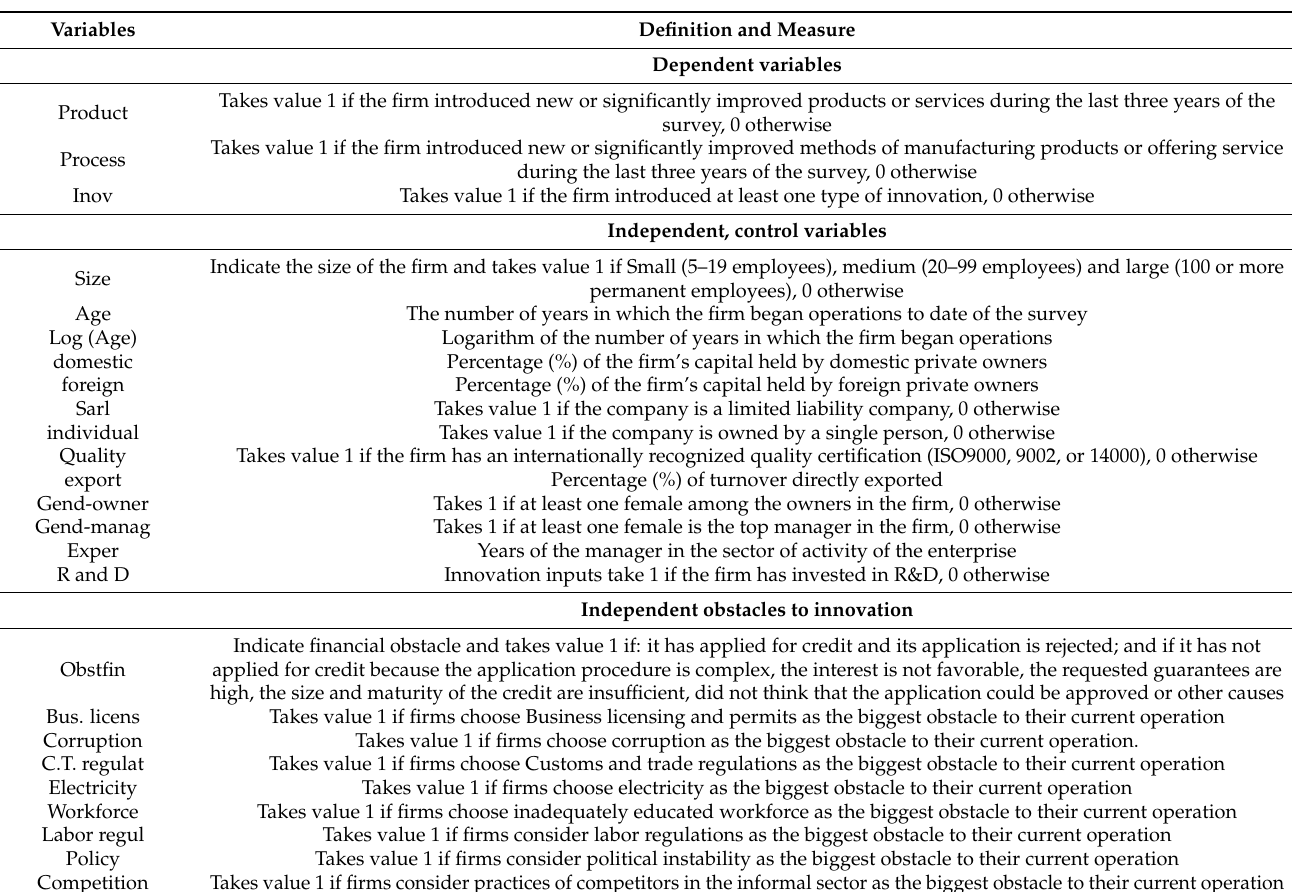
Table 1. Variables definition and